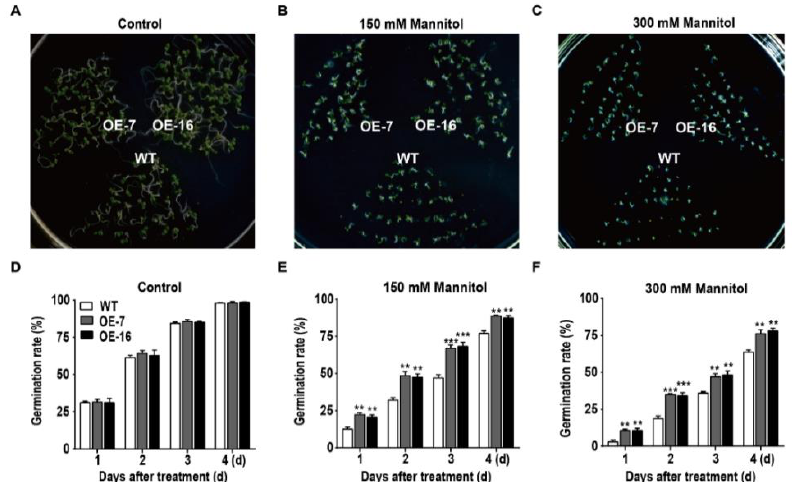
Figure 6. The germination rate of overexpressing TaWRKY46 in Arabidopsis under osmotic stress. WT and transgenic Arabidopsis seeds were sown on 1 / 2 MS medium containing 0 mM ( A , D ), 150 mM ( B , E ), and 300 mM mannitol ( C,F ). Panels ( A – C ) are the photos of germination status on media after 4 days; ( D – F ) are the diagrams of germination rate calculated for 4 days. Asterisks indicate a significant di ff erence between WT and transgenic Arabidopsis lines (** p < 0.01; *** p <